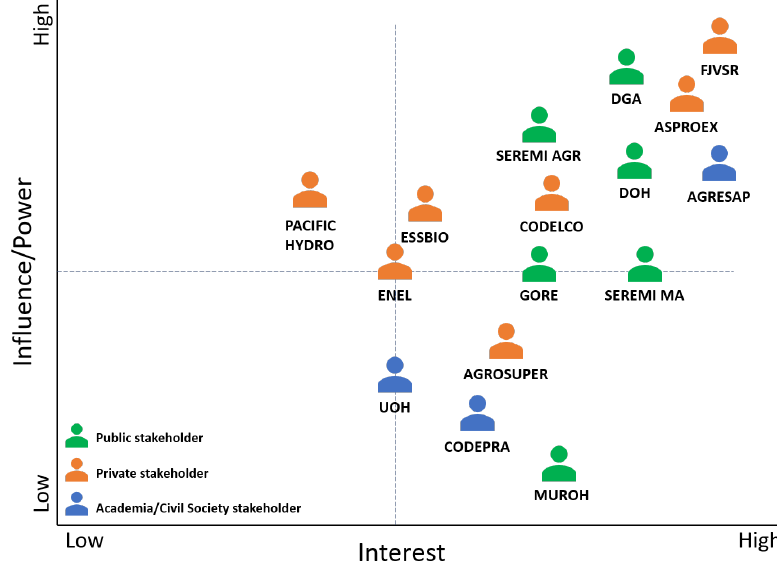
Figure 4. Influence-Interest map for stakeholders of the circle of influence (B) in the